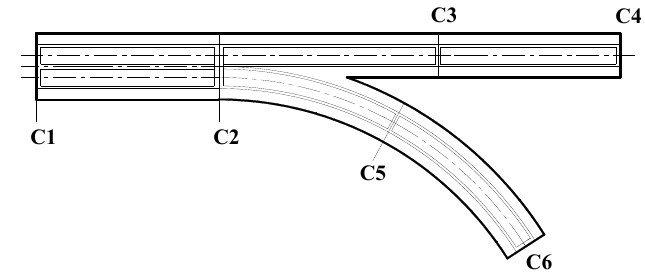
Figure 4. Bearing positions of the typical irregularly-shaped bridge.